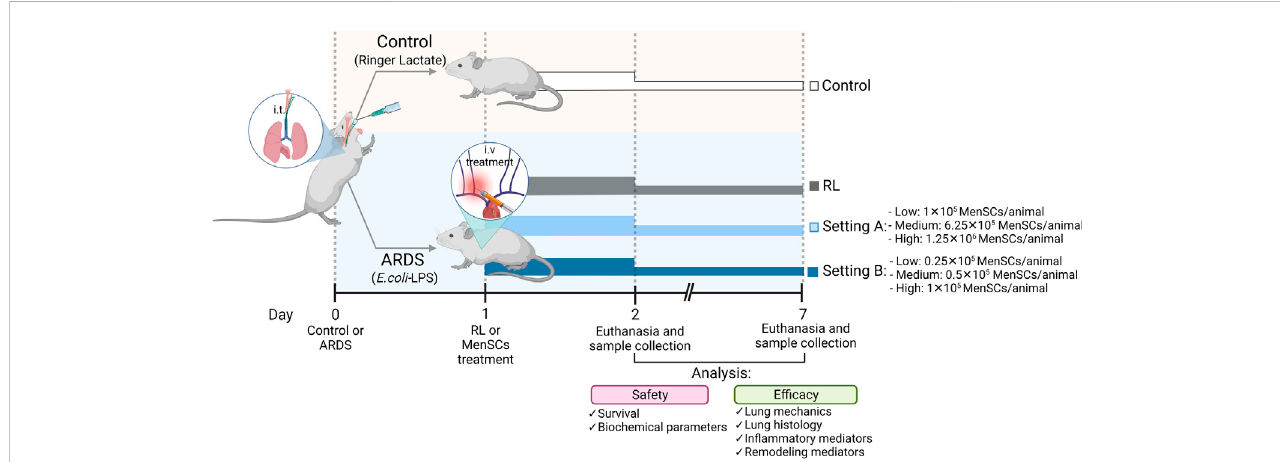
FIGURE 1 Scheme of the in vivo protocol for ARDS induced by LPS and treatment with cryopreserved-MenSCs. Flowchart of the experimental procedures for the ARDSmousemodel.Animalswererandomlyassignedtobeinthecontrol(CTRL)grouportheARDSgroup.TheCTRLgroupreceived50 μ LofRinger ’ slactate (RL),andtheARDSgroupreceived50 μ Lof Escherichiacoli lipopolysaccharide(LPS)(2 mg/kg),intratracheally(day0).After24 h(day1),theanimalswithARDS were randomly divided into those that were treated intravenously (50 μ L) through the jugular vein with RL (ARDS-RL group) or with MenSCs (ARDS- MenSCs group) at different doses according to each setting, A or B (n = 8 – 10 animals/group; setting A: 1×10 5 , 6.25×10 5 and 1.25×10 6 cryo-MenSCs/mouse; settingB:0.25×10 5 ,0.5×10 5 and1×10 5 MenSCs/mouse).Theevaluationandeuthanasiawereondays2and7afterARDSinductionorRLadministration.Figure created with